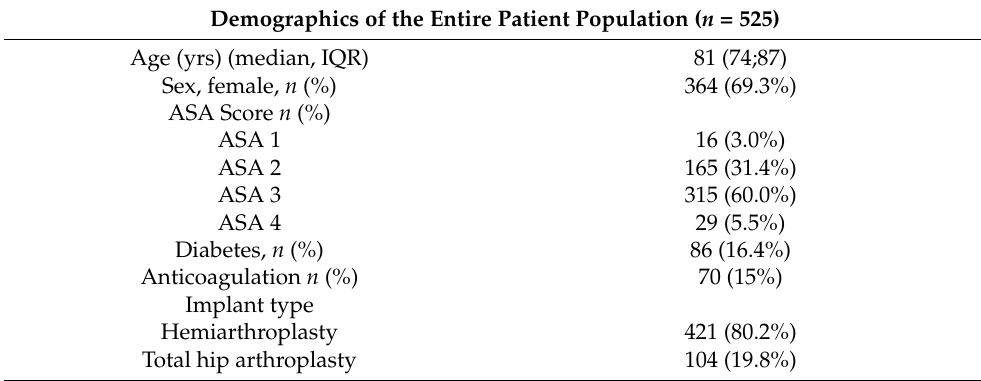
Table 1. Baseline